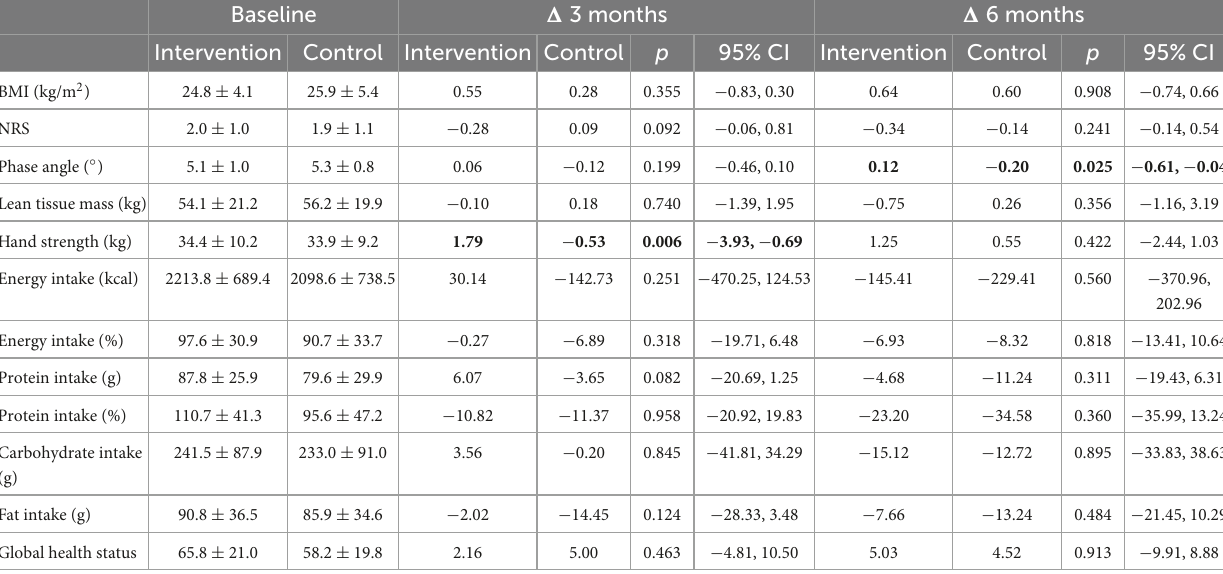
TABLE 2 Changes of nutritional status and quality of life after 3 and 6 months. Baseline (cid:49) 3 months (cid:49) 6 months Intervention Control Intervention Control